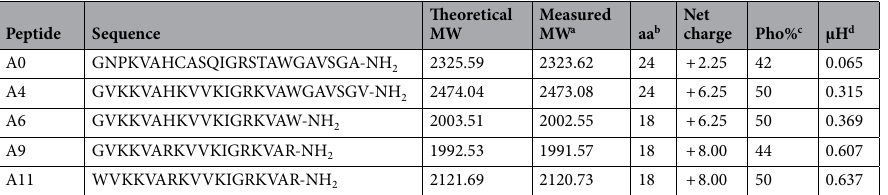
Table 2. Amino acid sequence and physicochemical properties of acidocin J1132β derivatives. a MW molecular weight (g/mol) measured by mass spectroscopy (MS). b aa, number of amino acids. c Pho%, the percentage of hydrophobic residues. d µH, the mean hydrophobic moment determined at website: http:// heliq uest. ipmc. cnrs.